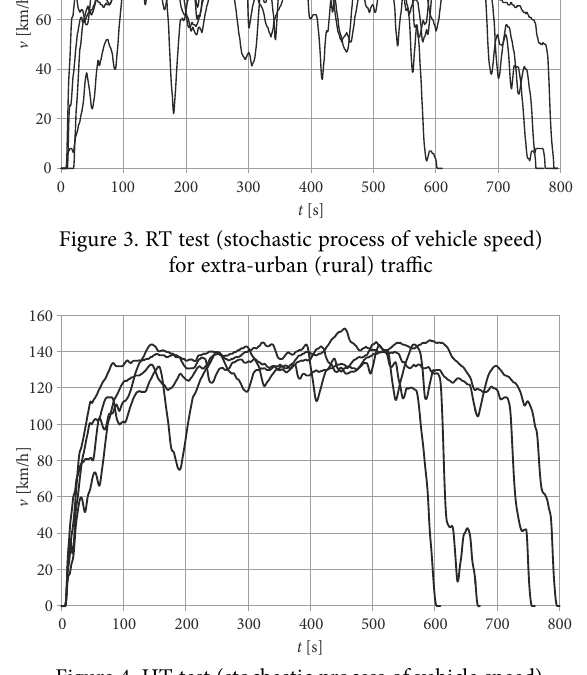
Figure 4. HT test (stochastic process of vehicle speed) for motorways and fast